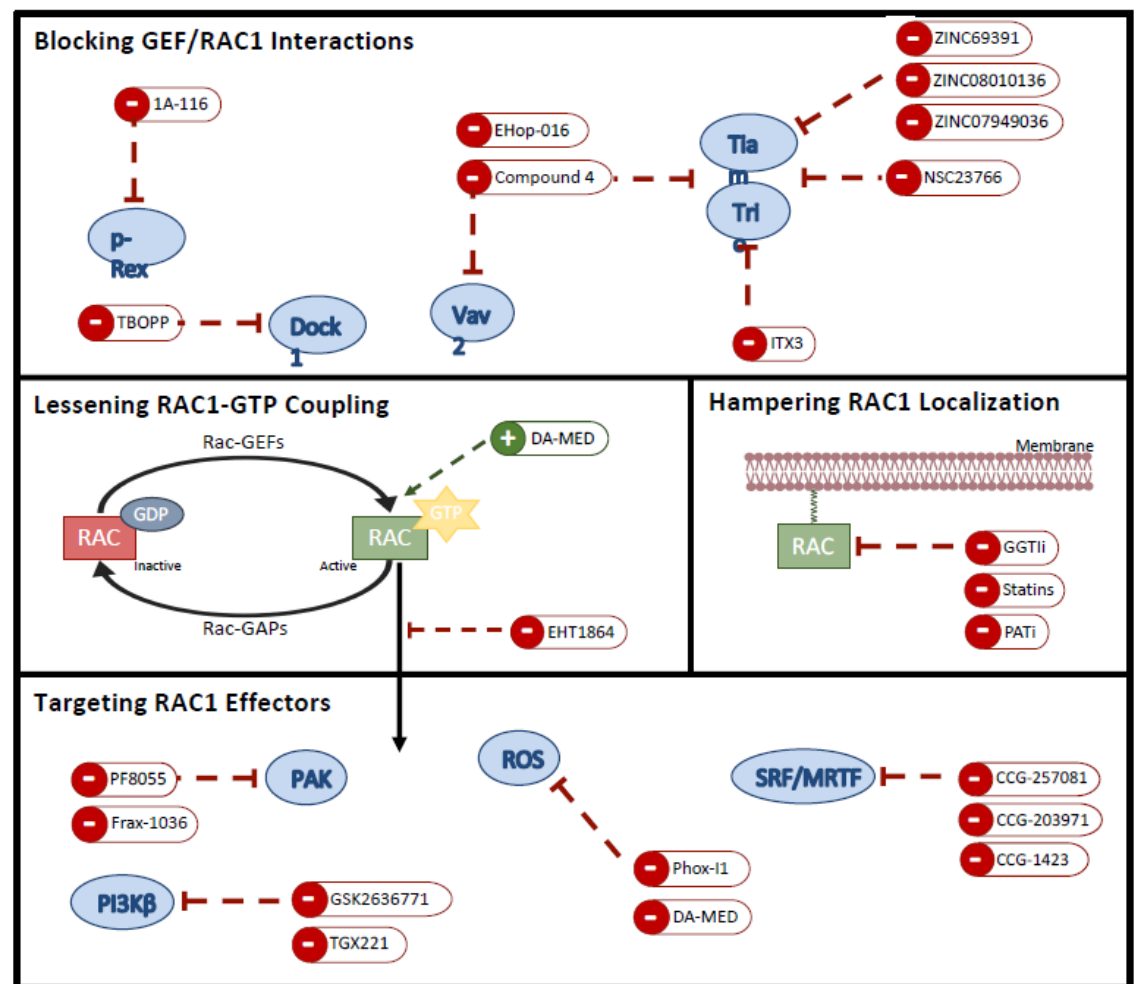
Figure 2. Targeting RAC1 in metastatic cutaneous melanoma. Current available inhibitors to target RAC1 pathway by blocking GEF-RAC1 interactions, lessening nucleotide binding, hampering RAC1 localization as well as by inhibiting downstream effector activity. Table 1. Compounds developed targeting RAC1 .